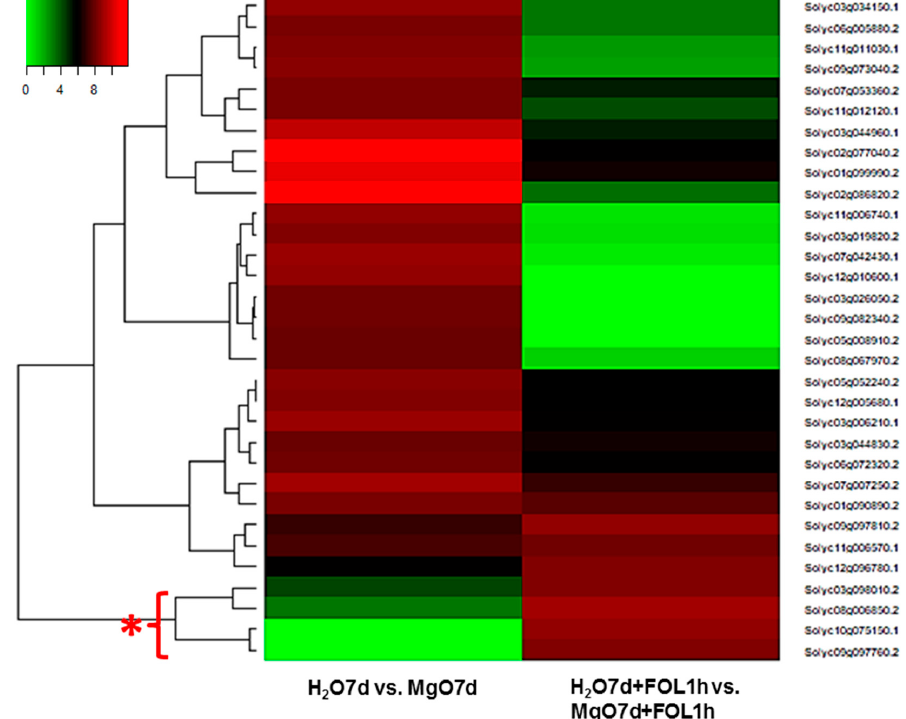
Figure 6. Heatmap analysis to detect genes that show remarkable upregulation (asterisk) when MgO-pretreated tomato plants were inoculated with Fusarium oxysporum f. sp. lycopersici compared to those before FOL inoculation.